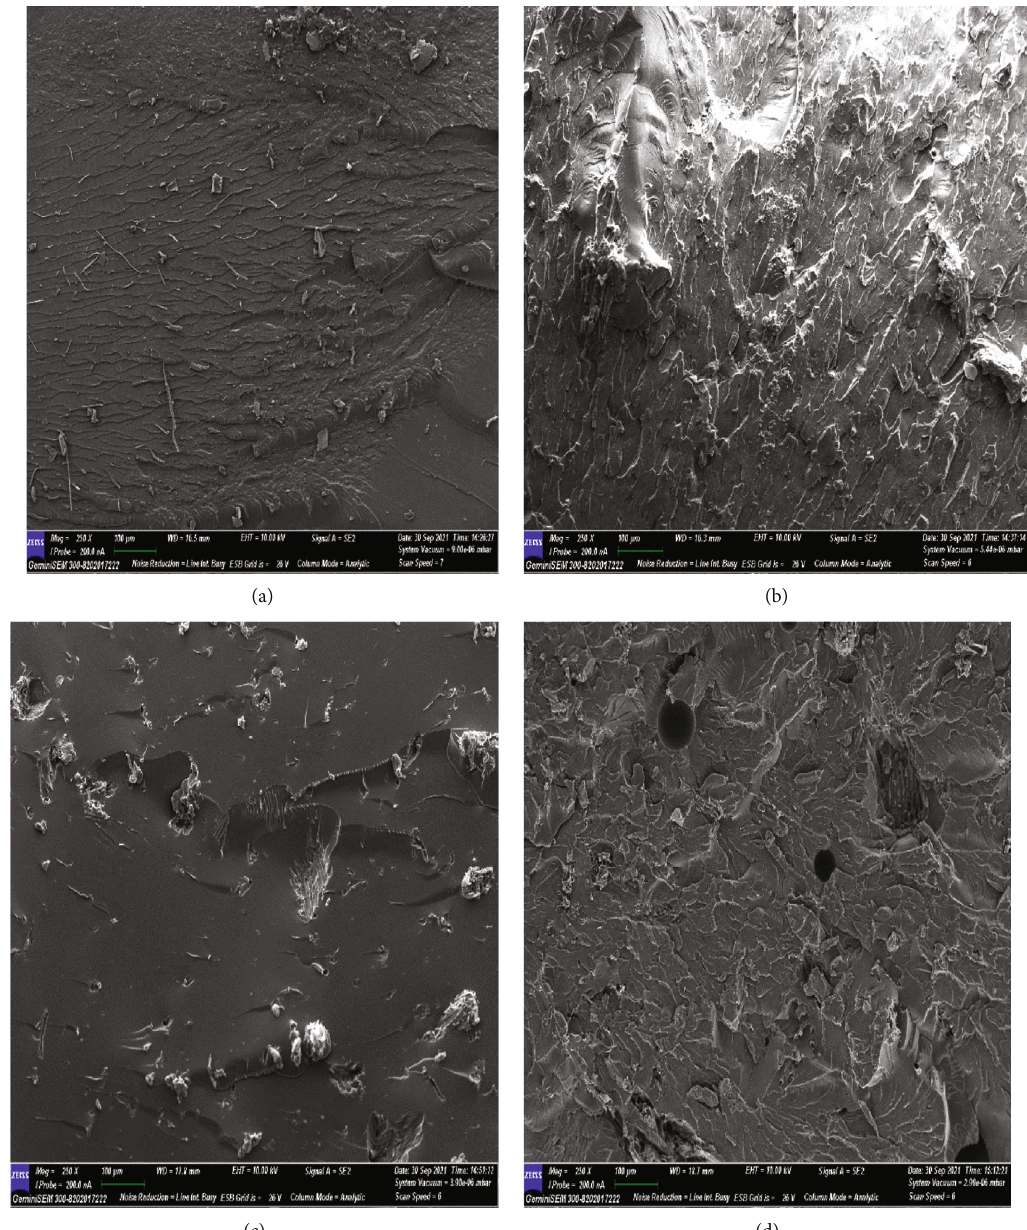
Figure 12: SEM images of tensile test failed composite surfaces for (a) M-0, (b) M-20, (c) M-40, and (d)